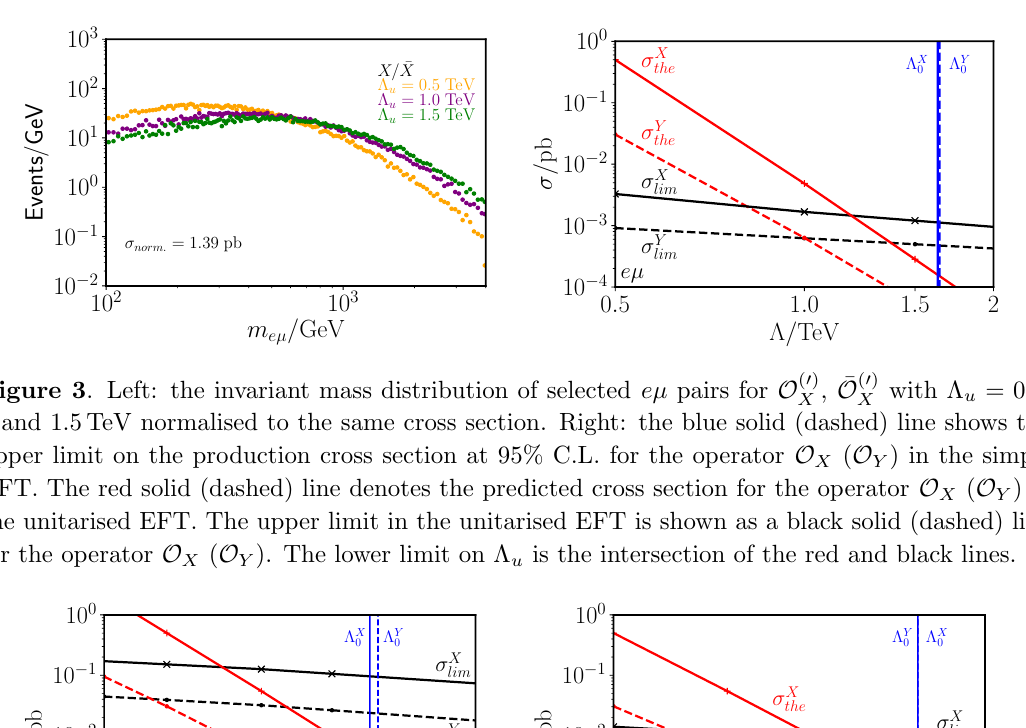
Figure 4 . The colours of the lines are the same as in the right part of (cid:12)gure 3. Left: operators with (cid:13)avours e(cid:28) . Right: operators with (cid:13)avours (cid:22)(cid:28) . The limits for the simple EFT lie on top of each other. Note the di(cid:11)erent ranges for